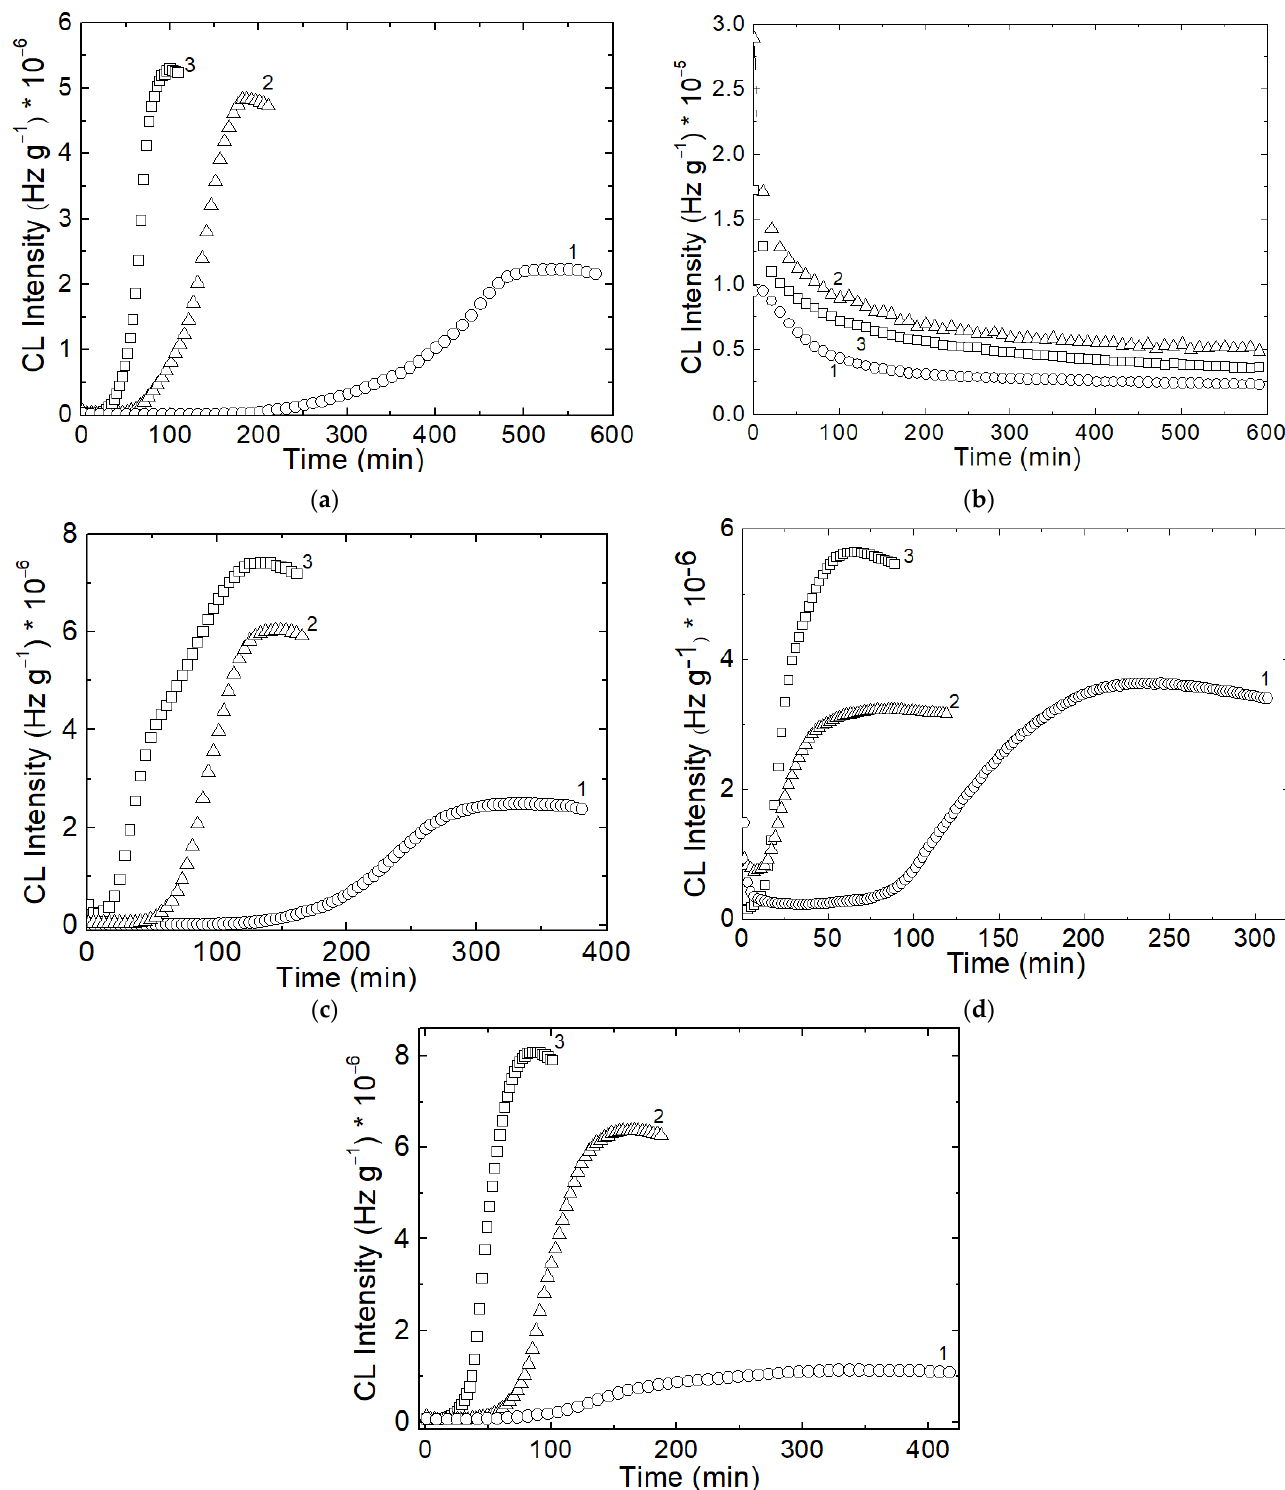
Figure 1. The isothermal CL spectra recorded on the unirradiated components and their blends: ( a ) neat SIS; ( b ) neat PCL; ( c ) SIS:PCL = 3:1; ( d ) SIS:PCL = 1:1; ( e ) SIS:PCL = 1:3; Testing temperatures: (1) 130 °C; (2) 140 °C; (3) 150 °C.